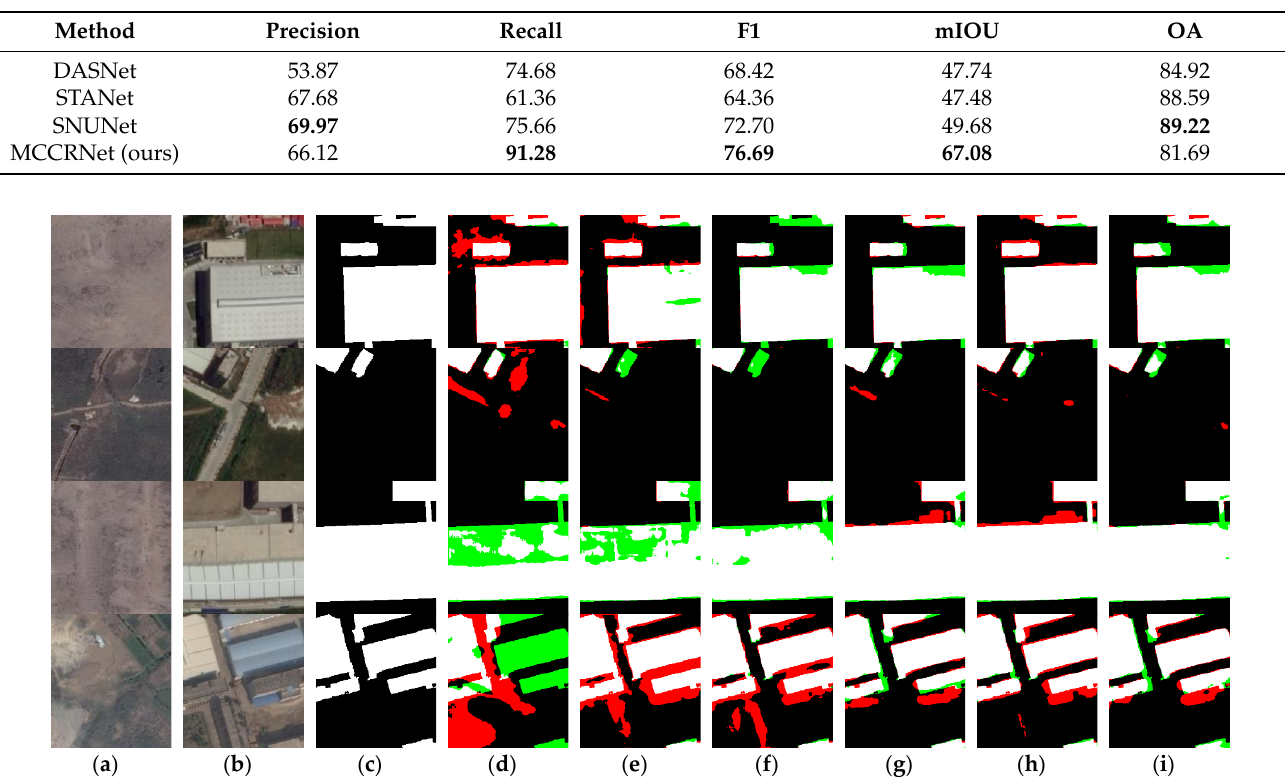
Figure 11. Visual comparison results on Google Data GZ dataset: ( a ) Image T1; ( b ) Image T2; ( c ) ground truth; ( d ) FC-Siam-conc; ( e ) U-Net++; ( f ) DASNet; ( g ) STANet; ( h ) SNUNet; ( i ) MCCRNet.